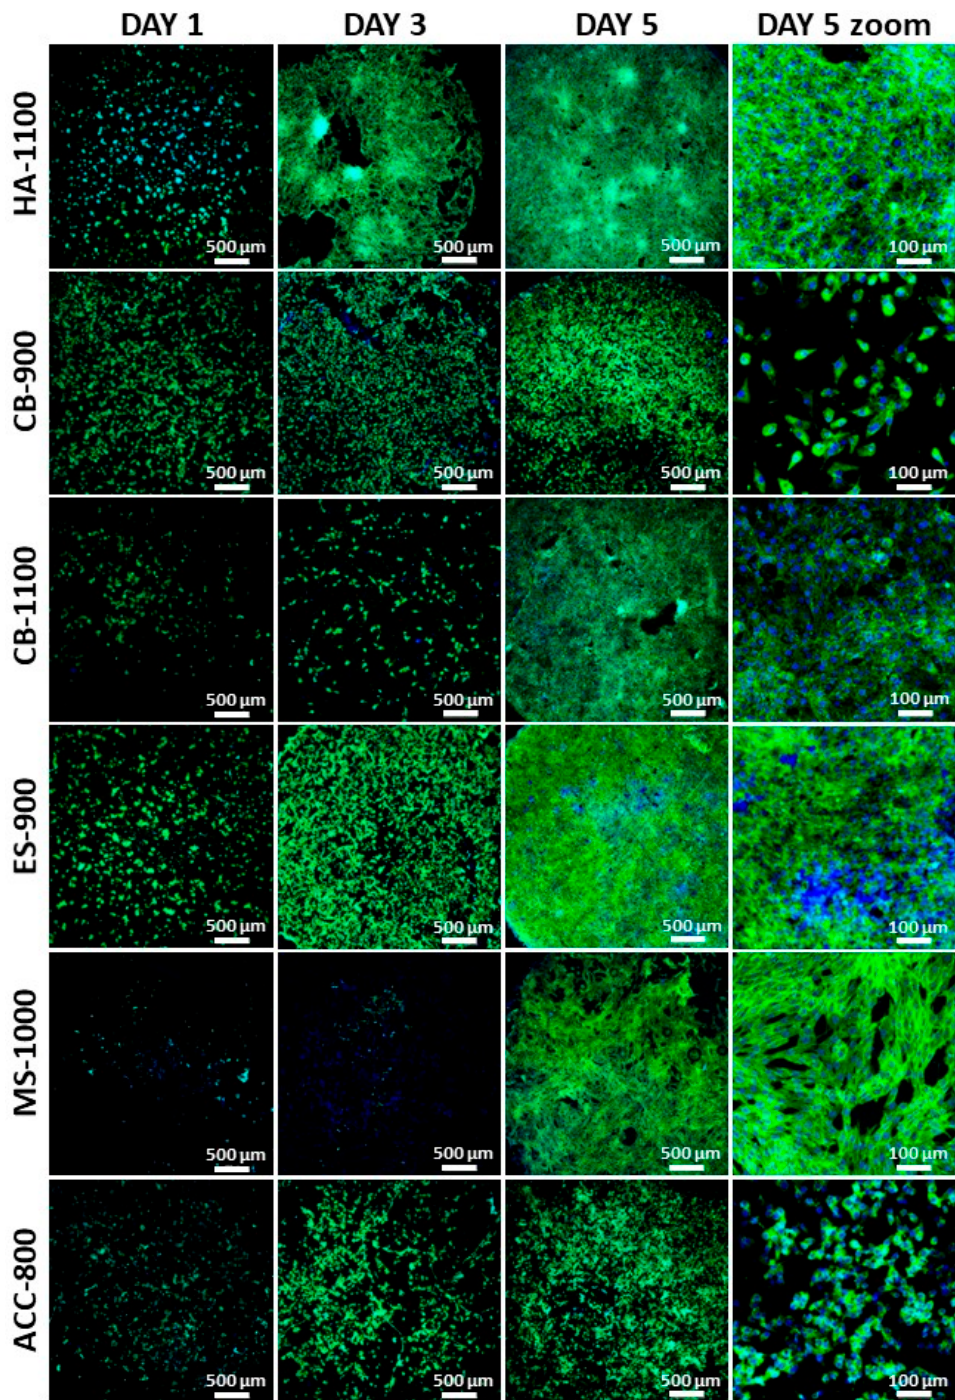
Figure 5. Confocal images of the cells adhered on the sintered pellets at day 1, 3 and 5 (the latter also with zoomed images).